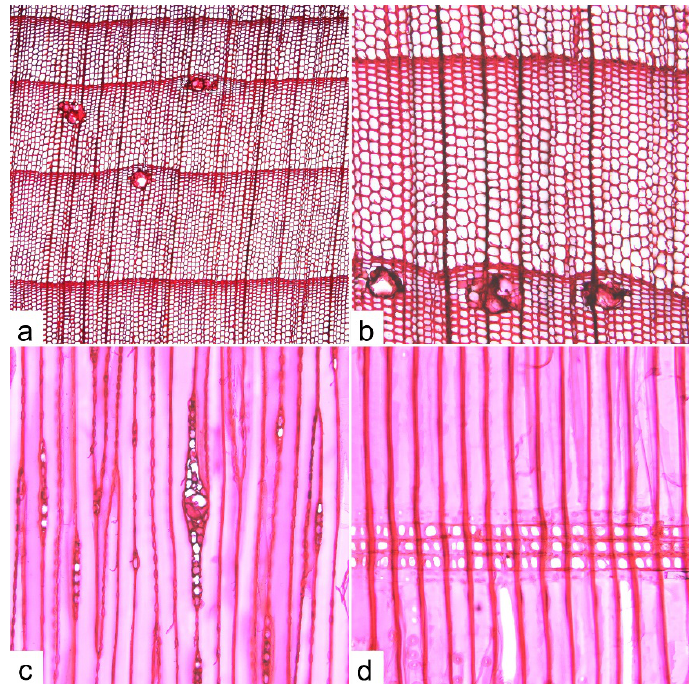
Figure 8. Himalayan pine— Pinus wallichiana A.B. Jacks—used as a timber in Gönpa Gang. Element no. UMGG10. Microscopic slides: ( a ) cross section in which the well-defined growth rings and the gradual transition from early to latewood is visible; ( b ) cross section—three resin canals located in the latewood are visible; ( c ) tangential section—uniseriate and fusiform rays are visible; ( d ) radial section—a heterogeneous ray with window-like pits in cross fields is visible.